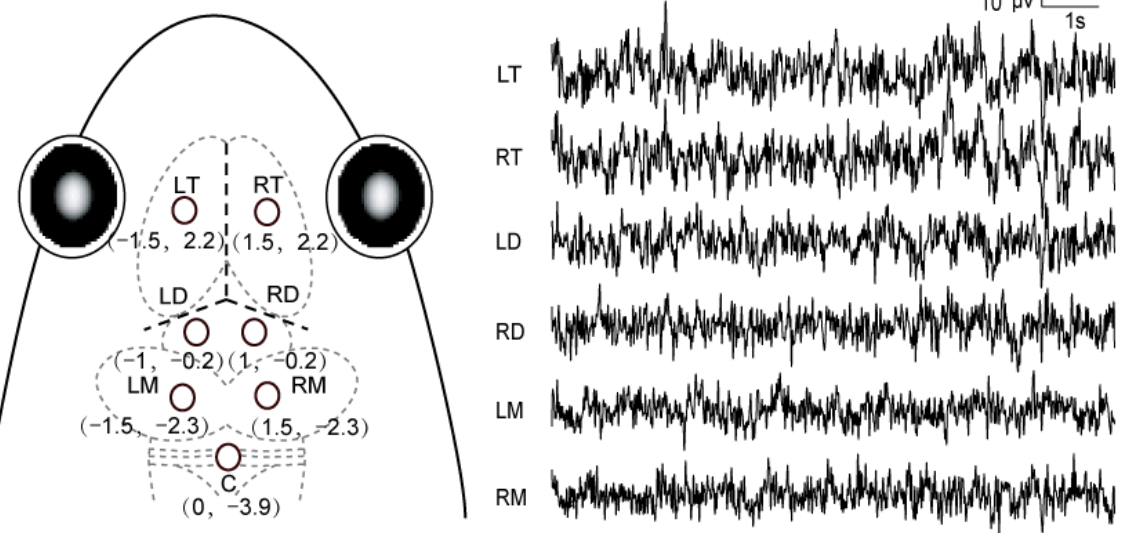
Figure 1. Schematic diagram showing electrode placements and 10 s typical raw unfiltered EEG tracings for each channel. Three dashed lines in bold indicate the intersection among the three suture lines in the frog skull. The first value for each electrode location was the mediolateral distance between this site and the midline, while the second one was the anteroposterior distance between the site and the intersection. LT and RT, both sides of the telencephalon; LD and RD, both sides of the diencephalon; LM and RM, both sides of the mesencephalon; C, the cerebellum.